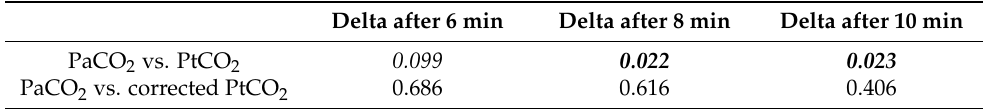
Table 3. p -values after the pairwise comparisons of deltas of PtCO 2 and corrected PtCO 2 with respect to deltas of PaCO 2 .